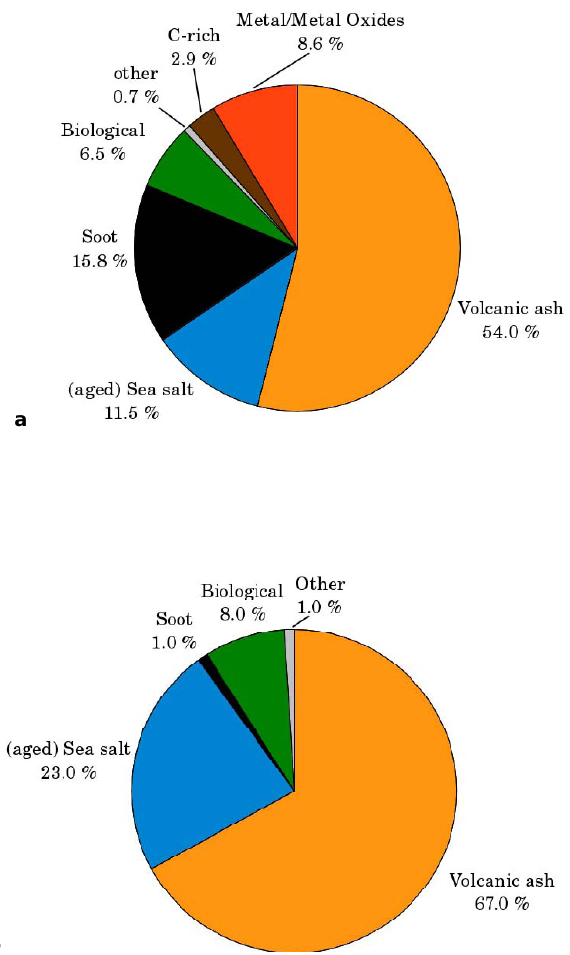
Fig. 4. Average relative number abundance of different particle groups among ice nuclei at TO during volcanic ash events: (a) April (samples #905 and #906) and (b) May (samples #945 and